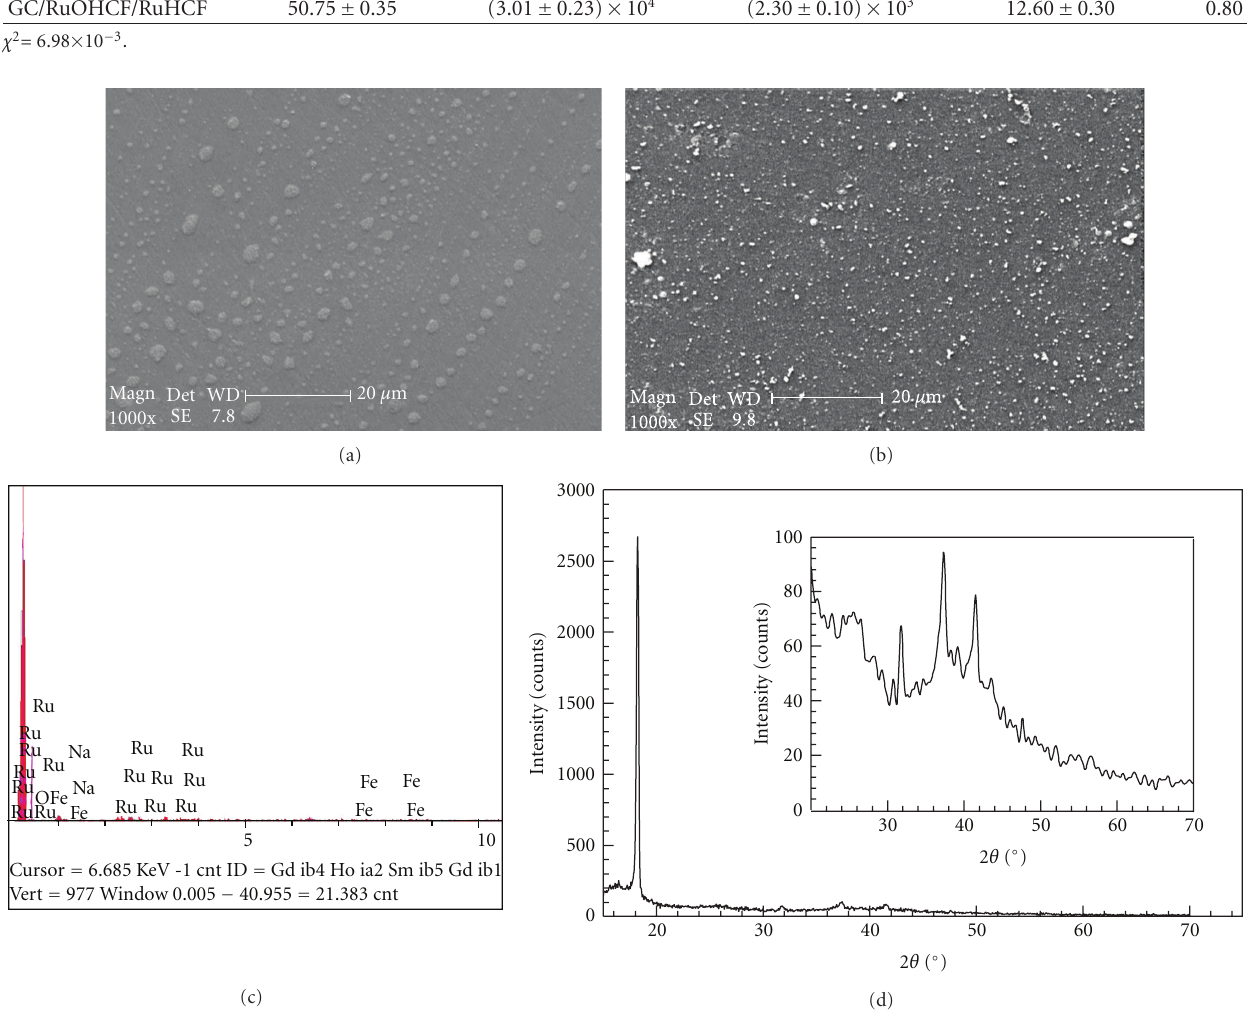
Figure 3: SEM microphotographs obtained on (a) the bare GC and (b) GC/RuOHCF/RuHCF modified electrodes. (c) EDX microanalysis spectrum and (d) XRD spectra of GC/RuOHCF/RuHCF modified electrode obtained using Cu K α 1.5406